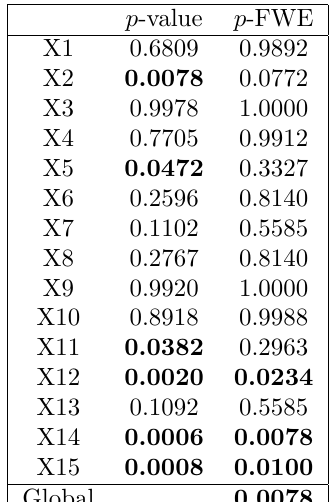
Raw and adjusted p -values from NPC